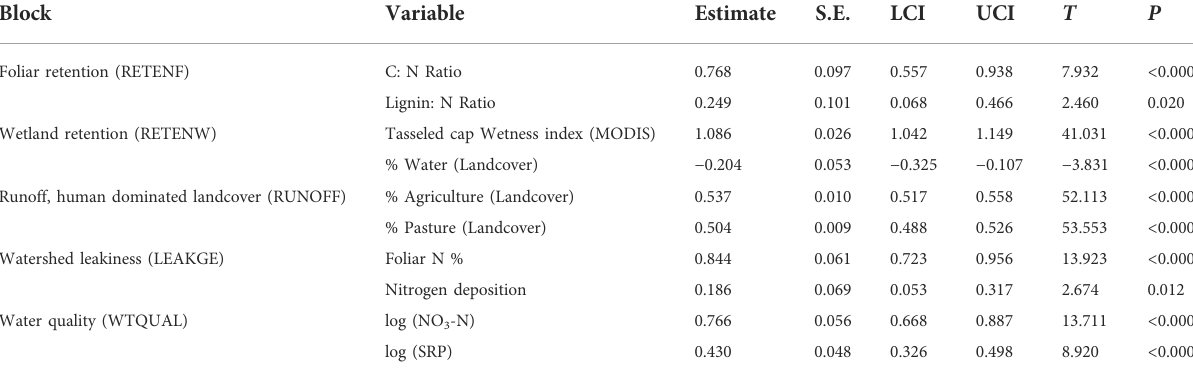
TABLE 5 Bootstrapped outer path weights (standardized coef fi cients of manifest variables on latent variables) for fi nal reduced variable model. Path weights are presented as estimates from 500 bootstrap estimates, accompanied by interquartile con fi dence intervals (LCI, UCI), associated T statistics and P - values. All effects are signi fi cant at p <